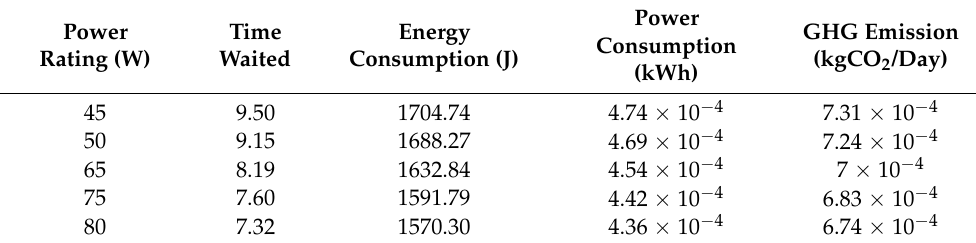
Table 1. GHG analysis for the single tank with respect to energy consumption.